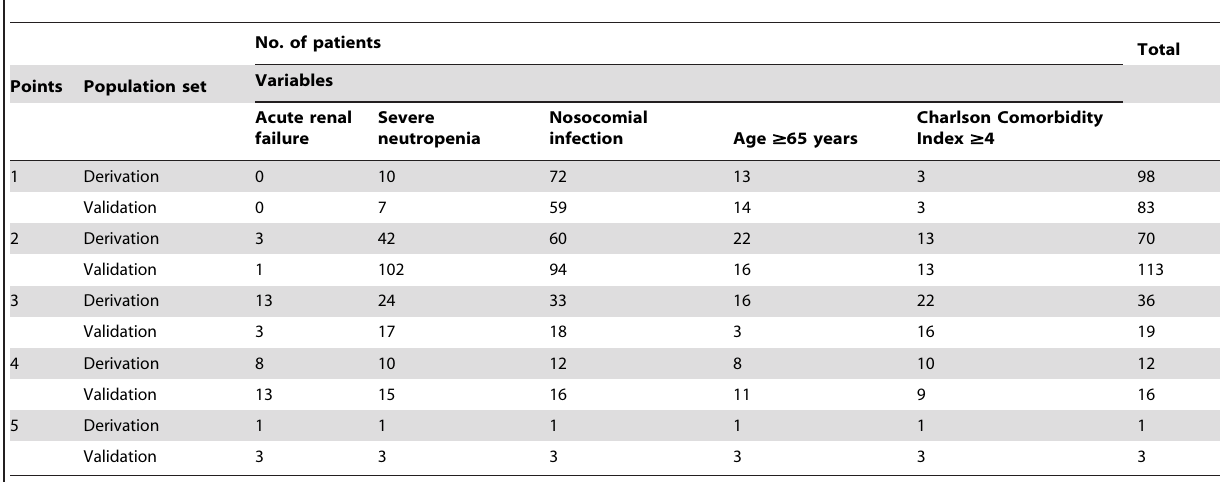
Table 4. Distribution of variables according to score points in the derivation and validation sets.